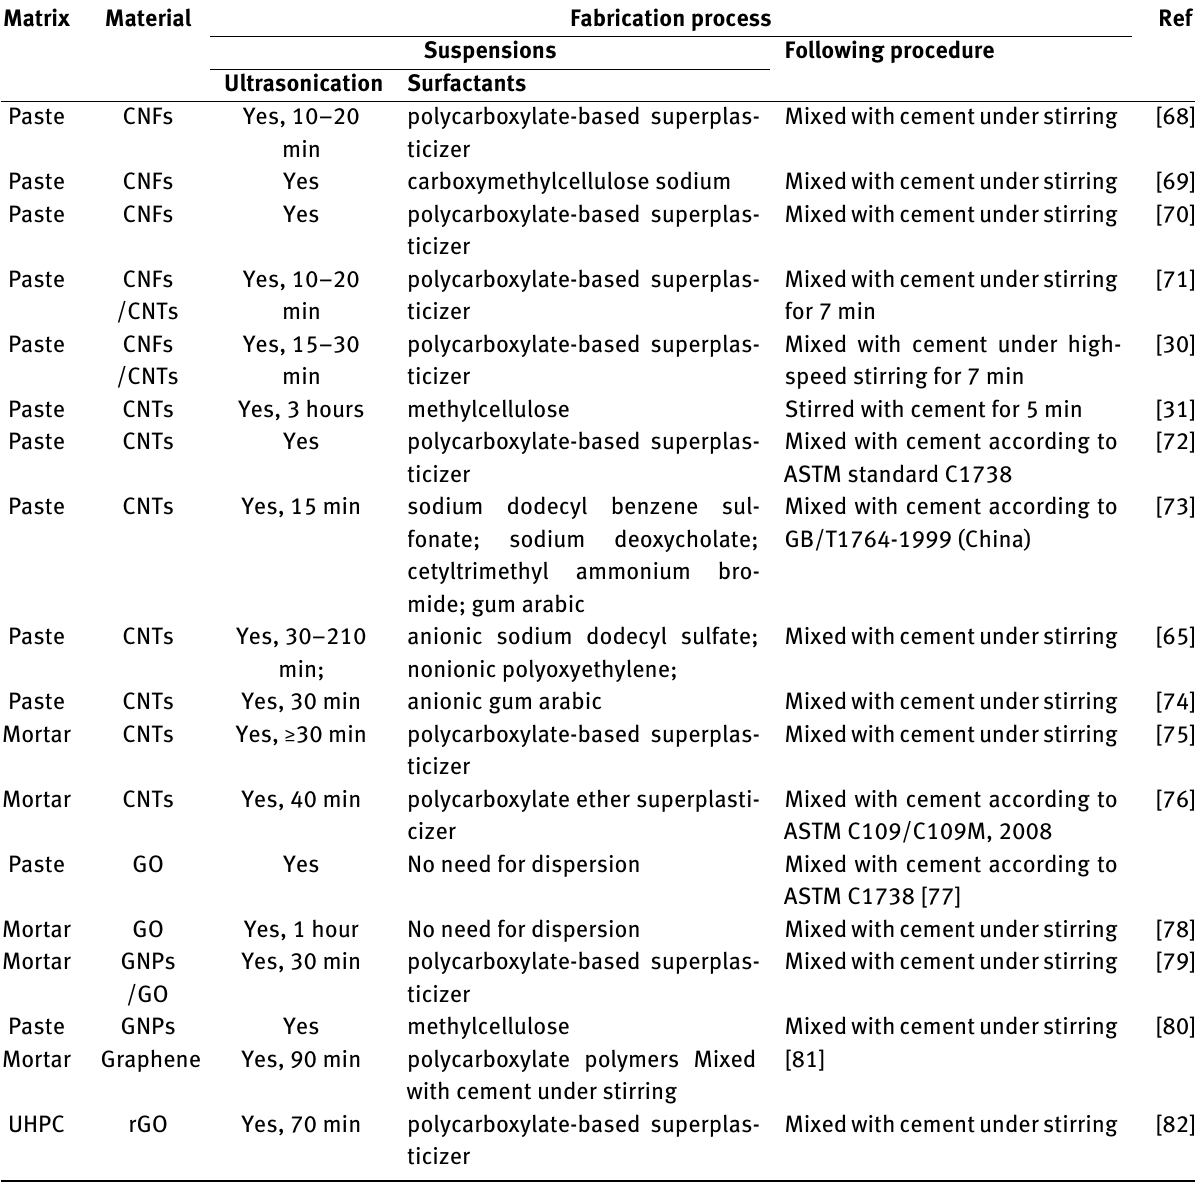
Table 2: Fabrication of carbon nanomaterials enhanced cement-based composites